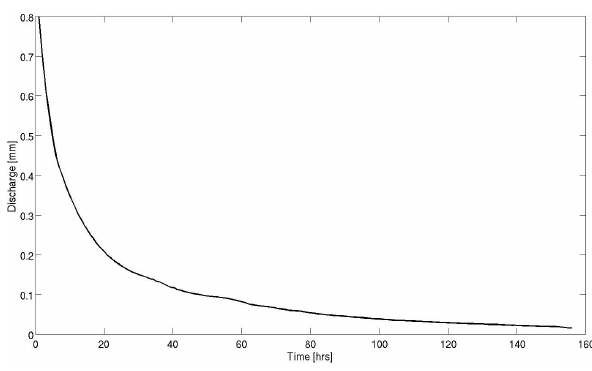
Fig. 2. Plot of the lower part of the master recession